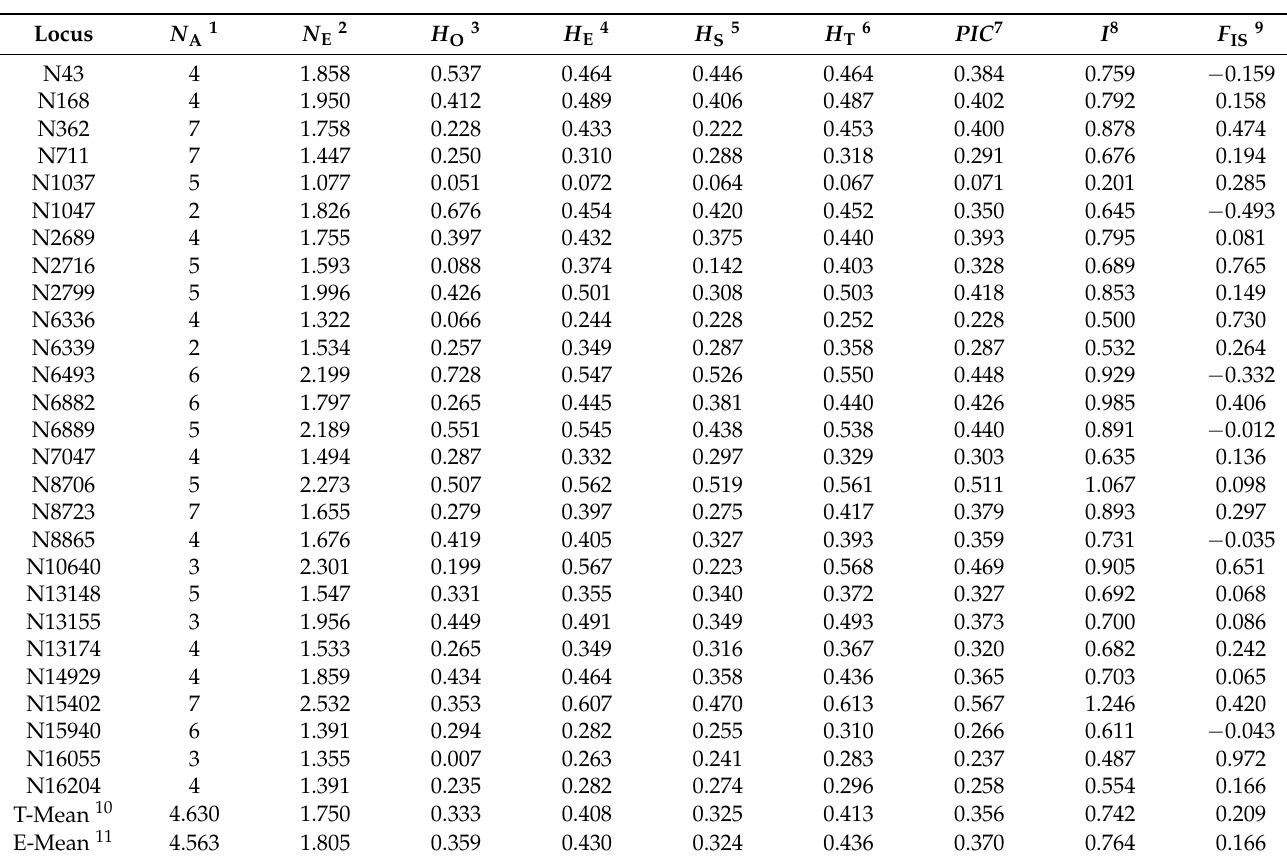
Table 2. Genetic characteristics of 27 polymorphic nSSRs in S. tzumu